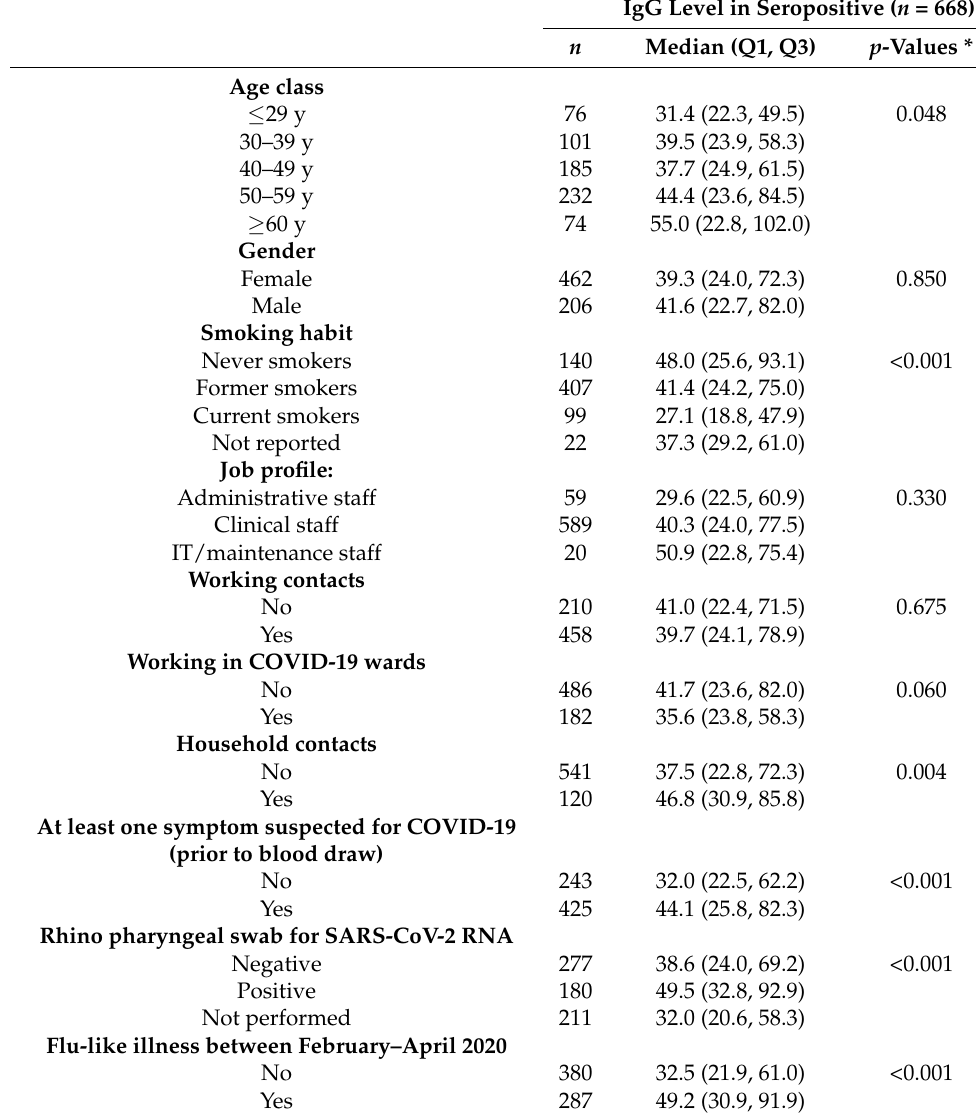
Table 4. Distribution of IgG levels at the first survey by demographic, clinical, and occupational characteristics among seropositive ( ≥ 15 AU/mL) CSS